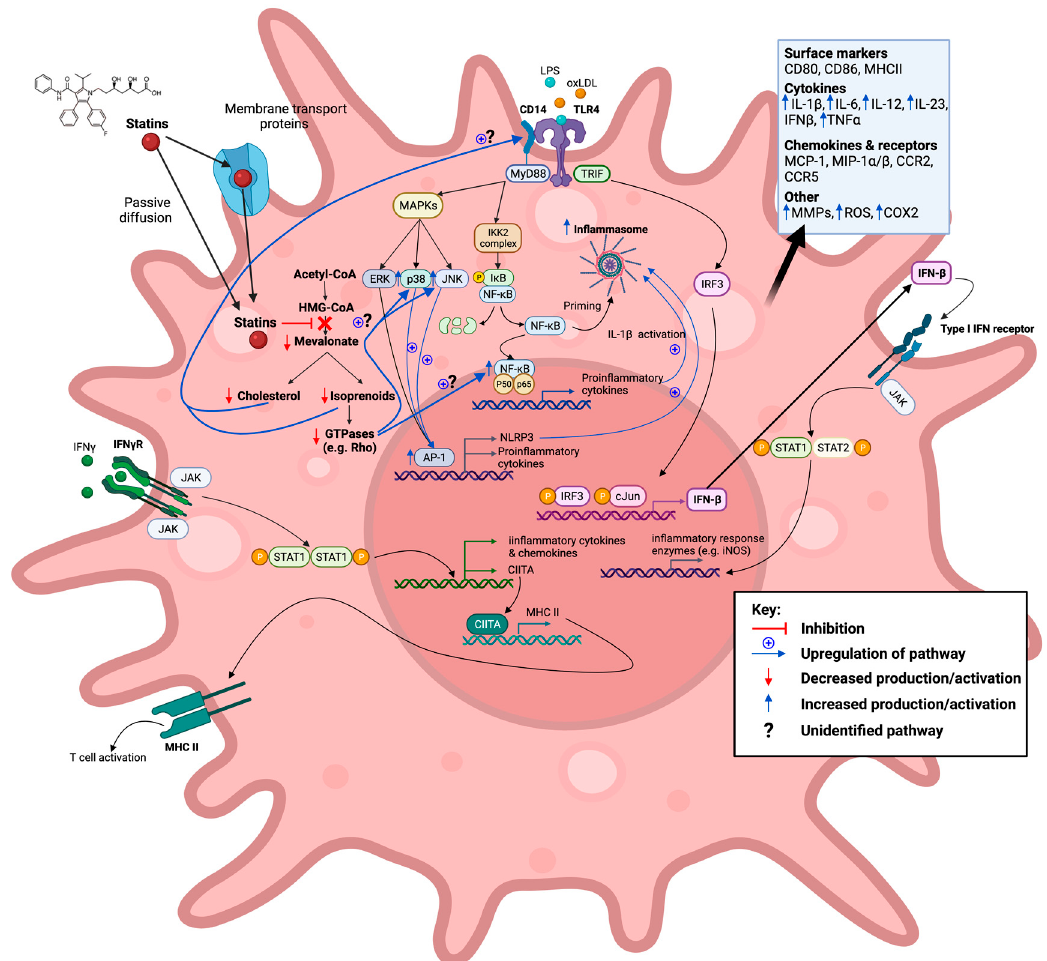
Figure 4. Statins inhibit the mevalonate pathway leading to both reduced cholesterol and isoprenoid biosynthesis, thereby also blocking farnesylation and geranylgeranylation of GTPases. Reduction in these downstream mevalonate intermediates is demonstrated to affect M1-associated macrophage inflammatory signalling pathways in vitro in a pro-inflammatory manner. This action of statins is seen in response to exogenous lipopolysaccharide (LPS) and oxidized low-density lipoprotein (oxLDL) ligands. Created with BioRender.com, accessed on 7 March